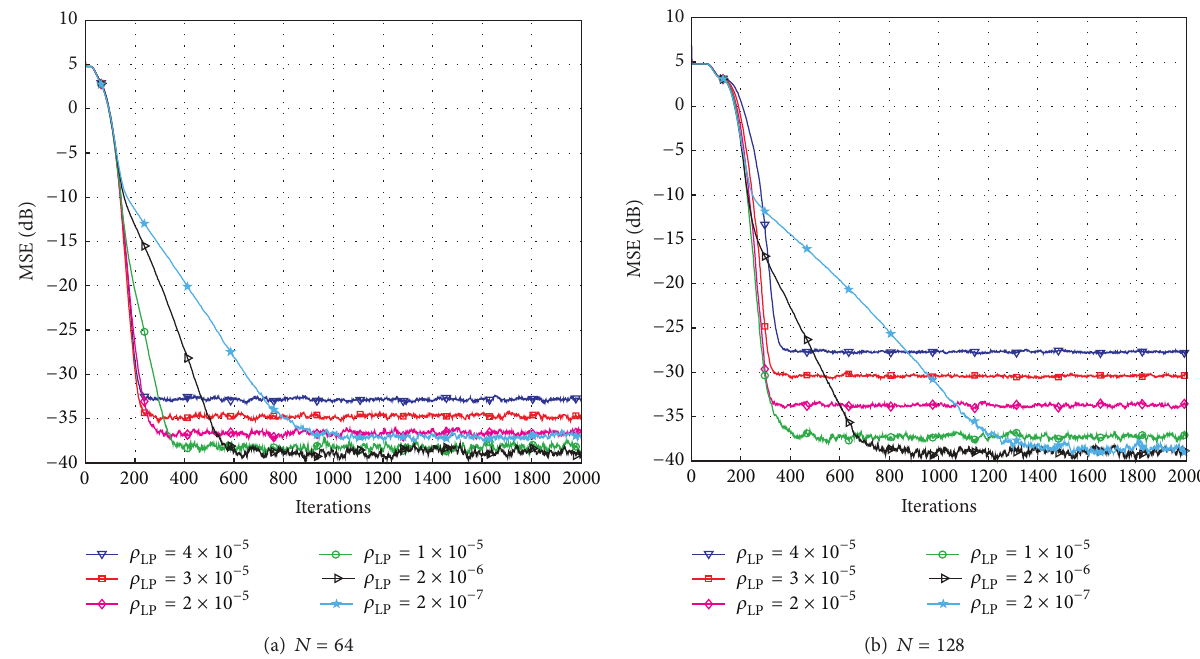
Figure 3: Effects of 𝜌